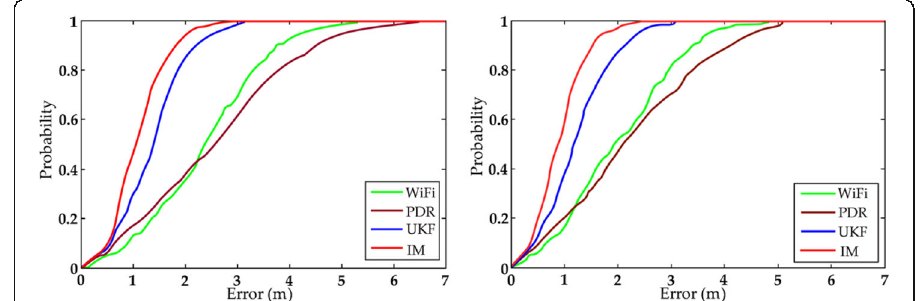
Fig. 9 Four approaches corresponding cumulative distribution functions of positioning error. a The first floor. b The third